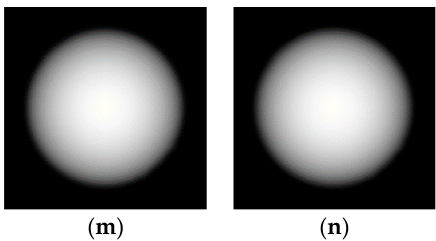
Figure A2. The decomposed background of Figure 1b by Fourier transform method with different parameter values. ( a – n ) are the decomposed background by Fourier transform method with 1th to 14th of filtering window sizes of [4:2:30], respectively.